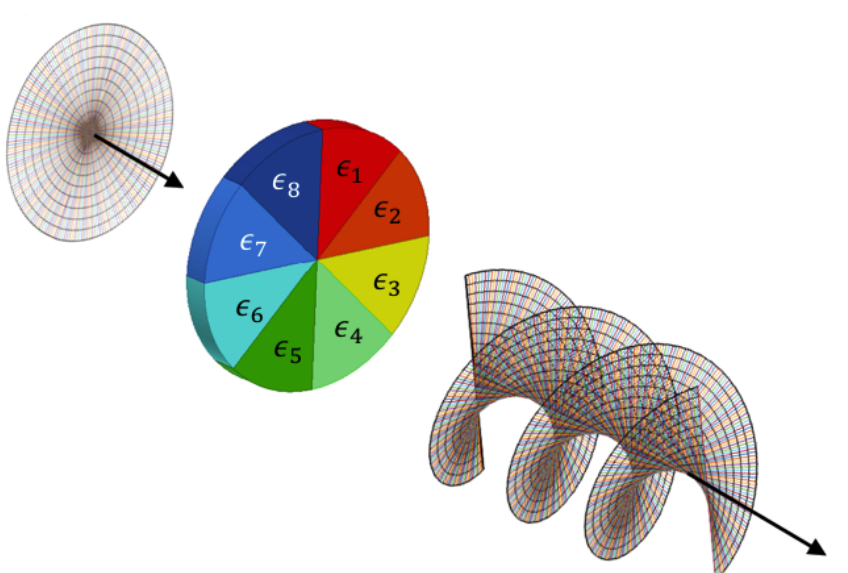
Figure 1. The incident plane wave transformation into OAM carrying wave by the proposed ferro- electric